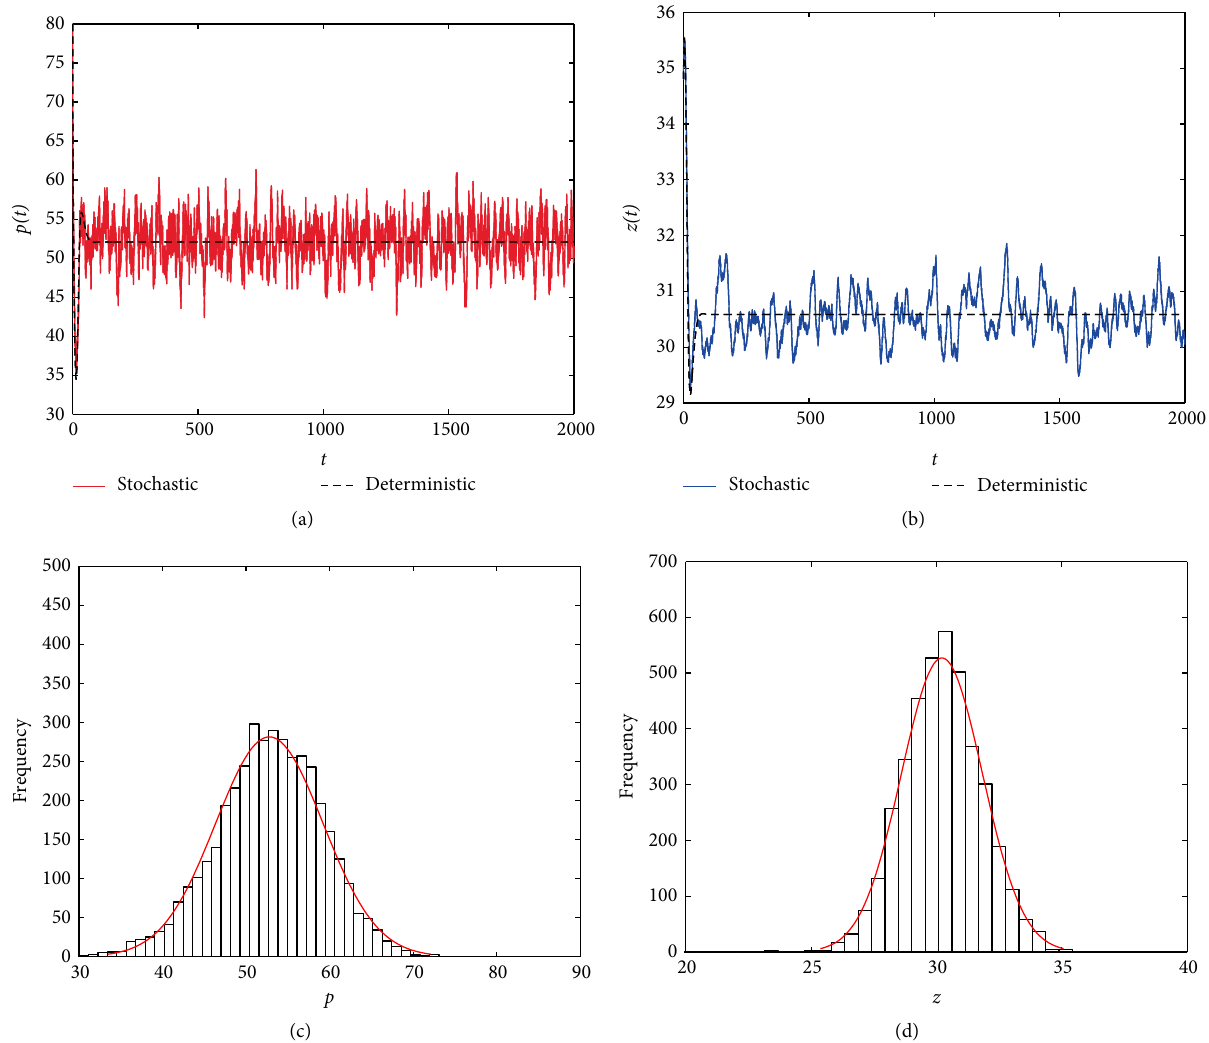
Figure 3: (a) and (b) are the solutions of system (2) and their corresponding deterministic system, respectively; (c) and (d) are the density , where 𝜎 0.03, 𝜎 0.0015 and other parameters are taken as Eq. function diagrams of 1 = 2 = ( 𝑝(𝑡), 𝑧(𝑡) )